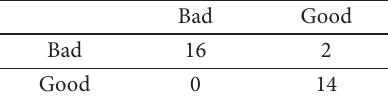
Table 3. Confusion matrix of the testing set Bad Good Bad 16 2 Good 0 14